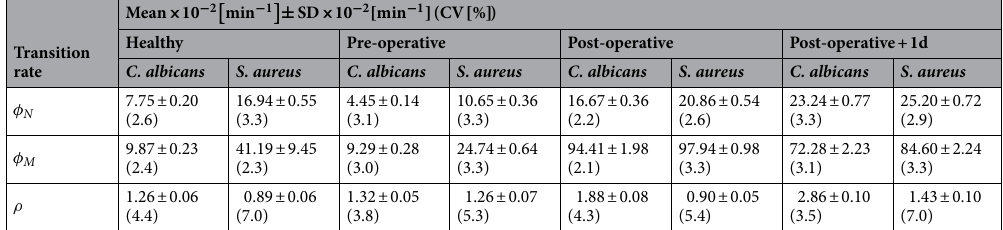
Table 1. Transition rate values of the SBM for C. albicans and S. aureus infection of blood samples taken from either healthy volunteers or HLM patients before cardiac surgery (pre-operative), immediately after surgery (post-operative) and one day after admission to intensive care (post-operative + 1d). The transition rate values are given by the phagocytosis rate φ N of neutrophils, the phagocytosis rate φ M of monocytes and the rate for acquiring immune escape ρ